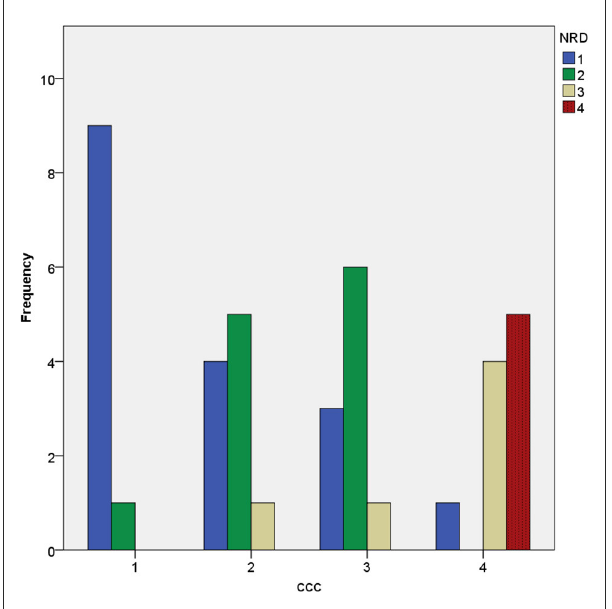
FIGURE4 Natural regeneration density (NRD) per crown cover class (CCC).